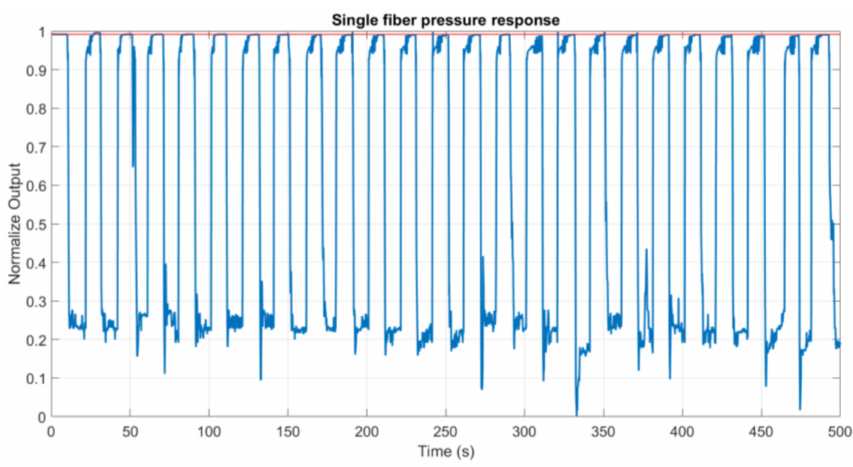
Figure 10. Cyclic loading test to verify the presence of a drift in the response, in red is represented the initial zero-pressure base